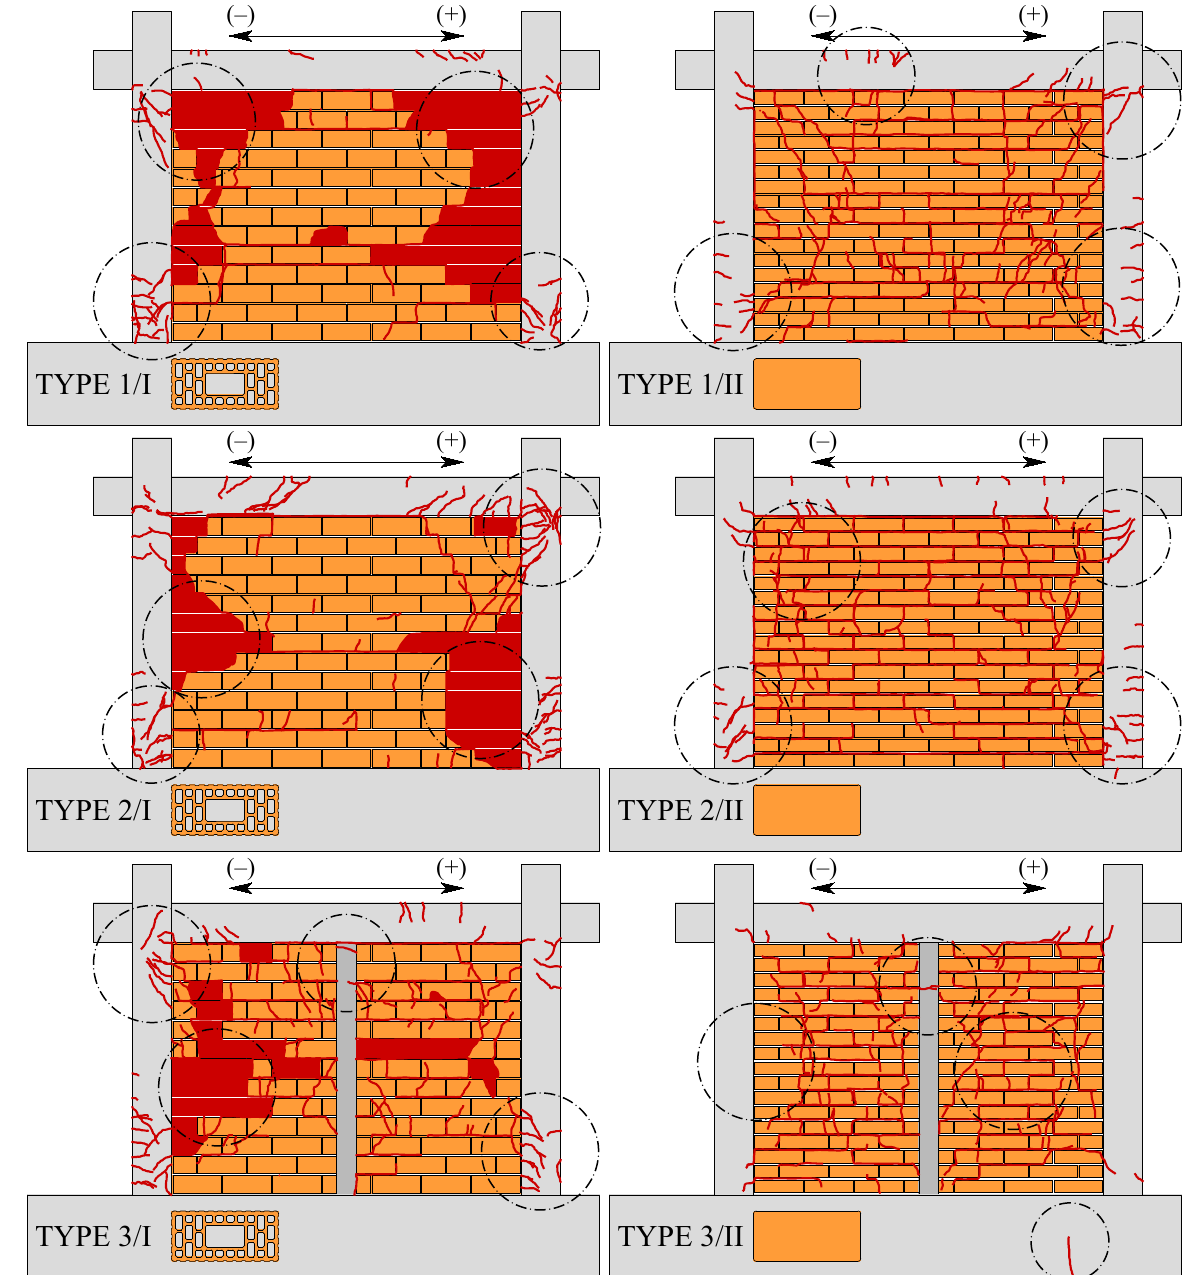
Figure 6. Crack patterns of RC beams, columns and masonry–infill of all tested